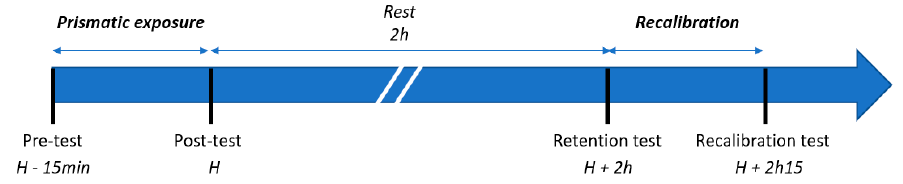
Figure 1. Protocol time course for prismatic exposure and recalibration. This figure illustrates the timeline of tests conducted in the study, which involves two main steps: prismatic exposure and recalibration, with a 2 h rest period in between. Each step comprises pre-test, exposure, and post-test steps. For the first step, the pre-test and post-test are labeled accordingly. For the second step, the pre-test is referred to as the “retention test”, and the post-test is known as the “recalibration test”.